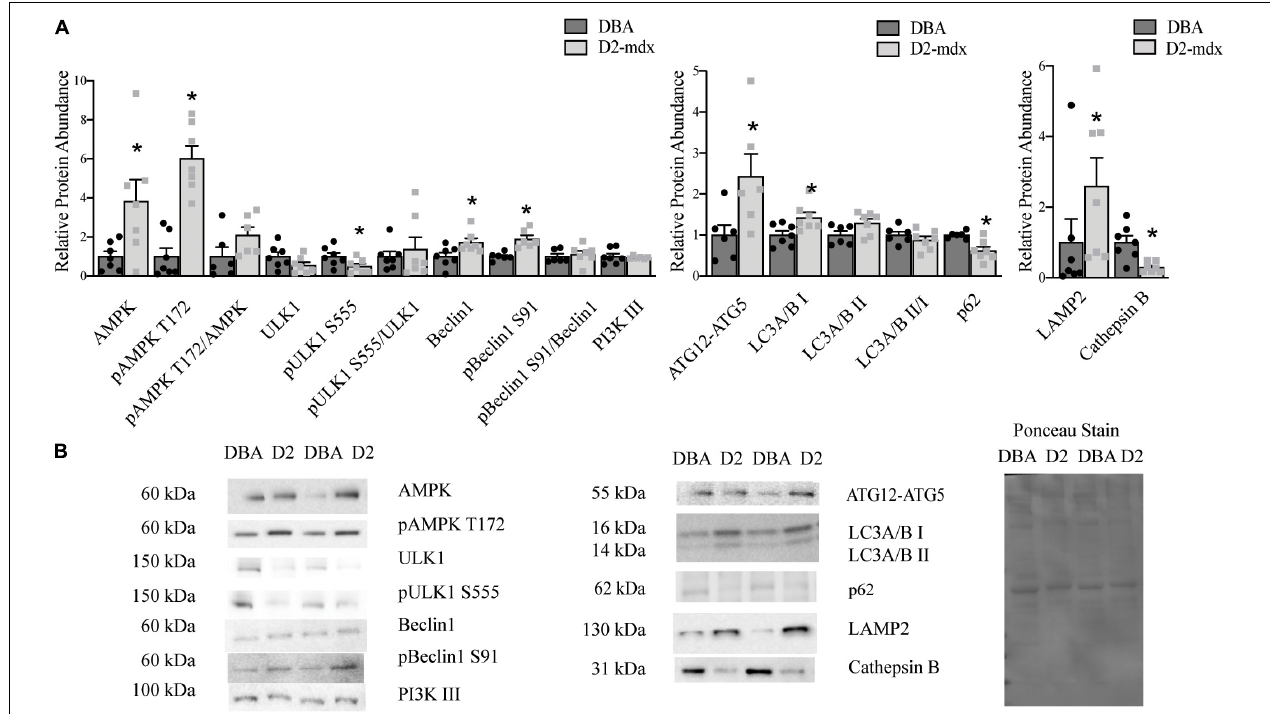
FIGURE 2 | Increased autophagosome degradation in gastrocnemius from D2-mdx. Western blot analysis of autophagy markers in whole muscle extract from 11 month old D2-mdx and DBA gastrocnemius. (A) Among the autophagy activation markers, AMPK, pAMPK T172, Beclin1 and pBeclin1 S91 were increased in dystrophic muscle compared to DBA whereas pULK1 S555 was reduced. The autophagosome formation marker ATG12-ATG5 was increased in D2-mdx gastrocnemius muscle compared to muscle from DBA. LC3I was increased and p62 was reduced in D2-mdx gastrocnemius muscle. The lysosomal marker LAMP2 was increased and lysosomal enzyme Cathepsin B was decreased in muscle from D2-mdx compared to DBA. (B) Representative western blot images and corresponding Ponceau stain image. Significance is established at p < 0.05. * Indicates significance between D2-mdx and DBA ( n = 7 mice per